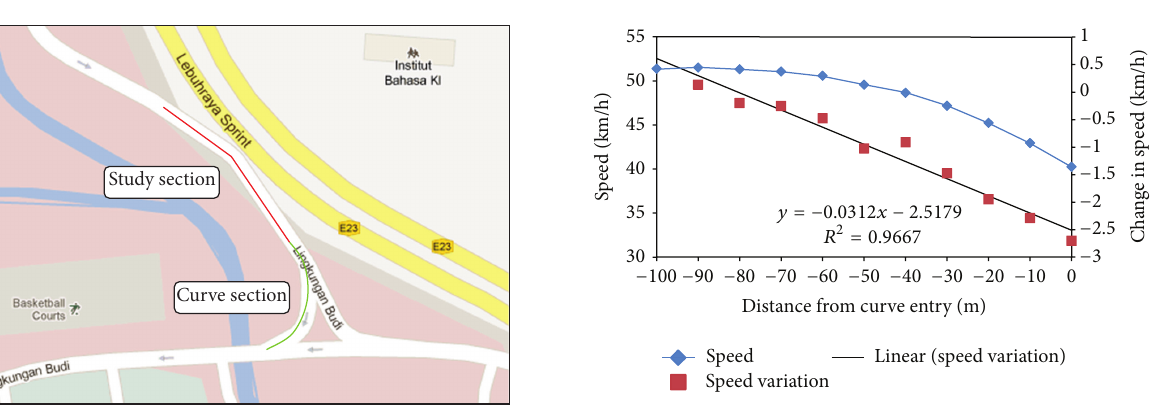
Figure 3: Plan view of study site.